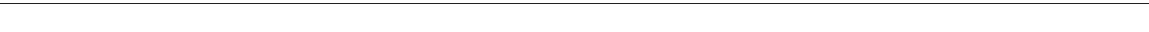
Fig. 5 HLA Class II chromatin landscapes of HLA-DR3 and DR15 haplotypes. a CTCF HiChIP looping interactions within the HLA Class II region reveal an insulated neighborhood that extends from BTNL2 to upstream of HLA-DQA2 . The COX-aligned DR3 haplotype is presented on top and the PGF-aligned DR15 haplotype is presented on the bottom. Gene and bp positions are presented speci fi c for each haplotype. Orange arcs represent CTCF-mediated HiChIP interactions. Arc thickness is proportional to the frequency of observed paired-end tags (PETs) at each enhancer. b H3K27ac HiChIP looping interactions within the HLA Class II region reveal differential frequency and pattern in the HLA-DRB1 to HLA-DQB1 region between the HLA-DR15 and HLA- DR3 haplotypes. Black arcs represent H3K27ac-mediated HiChIP interactions. Signi fi cant p -values are presented for enhancers that exhibit differential binding frequencies (mean PETs) for one haplotype or the other and are colored by the haplotype that exhibits higher PET counts (HLA-DR3: blue; HLA- DR15: red). H3K27ac ChIP peaks are presented in blue (HLA-DR3) and red (HLA-DR15). Haplotype speci fi c loops are indicated in blue (COX) or red (PGF). Corresponding haplotype speci fi c enhancers are labeled as follows — COX: 1: 4.007 – 4.013 Mb, 2: 4.021 – 4.031 Mb, 3: 4.039 – 4.047 Mb, 4: 4.052 – 4.06 Mb, 5: 4.078 – 4.083 Mb; PGF: 1: 4.076 – 4.081 Mb, B : 4.092 – 4.102 Mb, C : 4.111 – 4.120 Mb, D : 4.124 – 4.129 Mb, E : 4.154 – 4.159 Mb. c Individual H3K27 HiChIP looping interactions for three subjects heterozygous for HLA-DR3 (left) and three subjects homozygous for HLA-DR15 (right). H3K27ac ChIP peaks, haplotype speci fi c loops, and haplotype speci fi c enhancers are presented in blue (HLA-DR3) and red